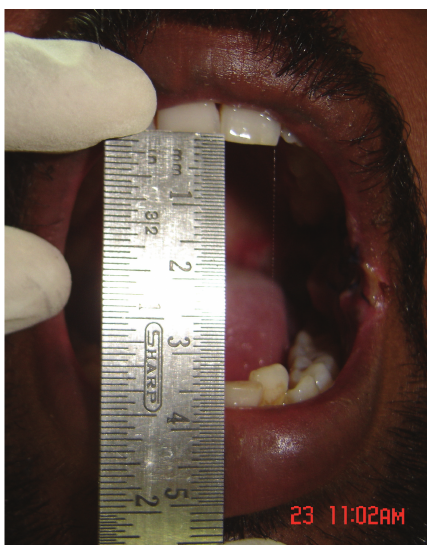
Figure 4: Buccal fat pad sutured (Intraop).